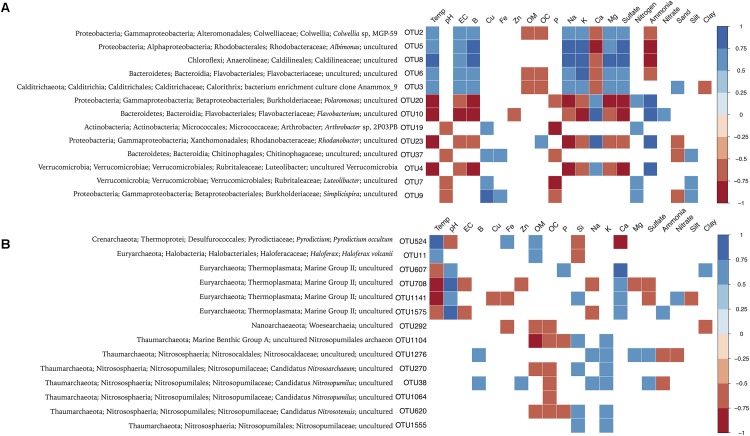
Spearman correlation between bacterial (A) and archaeal (B) abundant OTUs (>1% of relative abundance) and environmental parameters. Only parameters that exhibited p < 0.05 in correlations analysis are represented. The environmental parameters are: Temp (temperature), pH, EC (electrical conductivity), B, Cu, Fe, Zn, OM (organic matter), OC (organic carbon), P, Si, Na, K, Ca, Mg, sulfate, nitrogen, ammonia, nitrate, sand, silt, and clay.